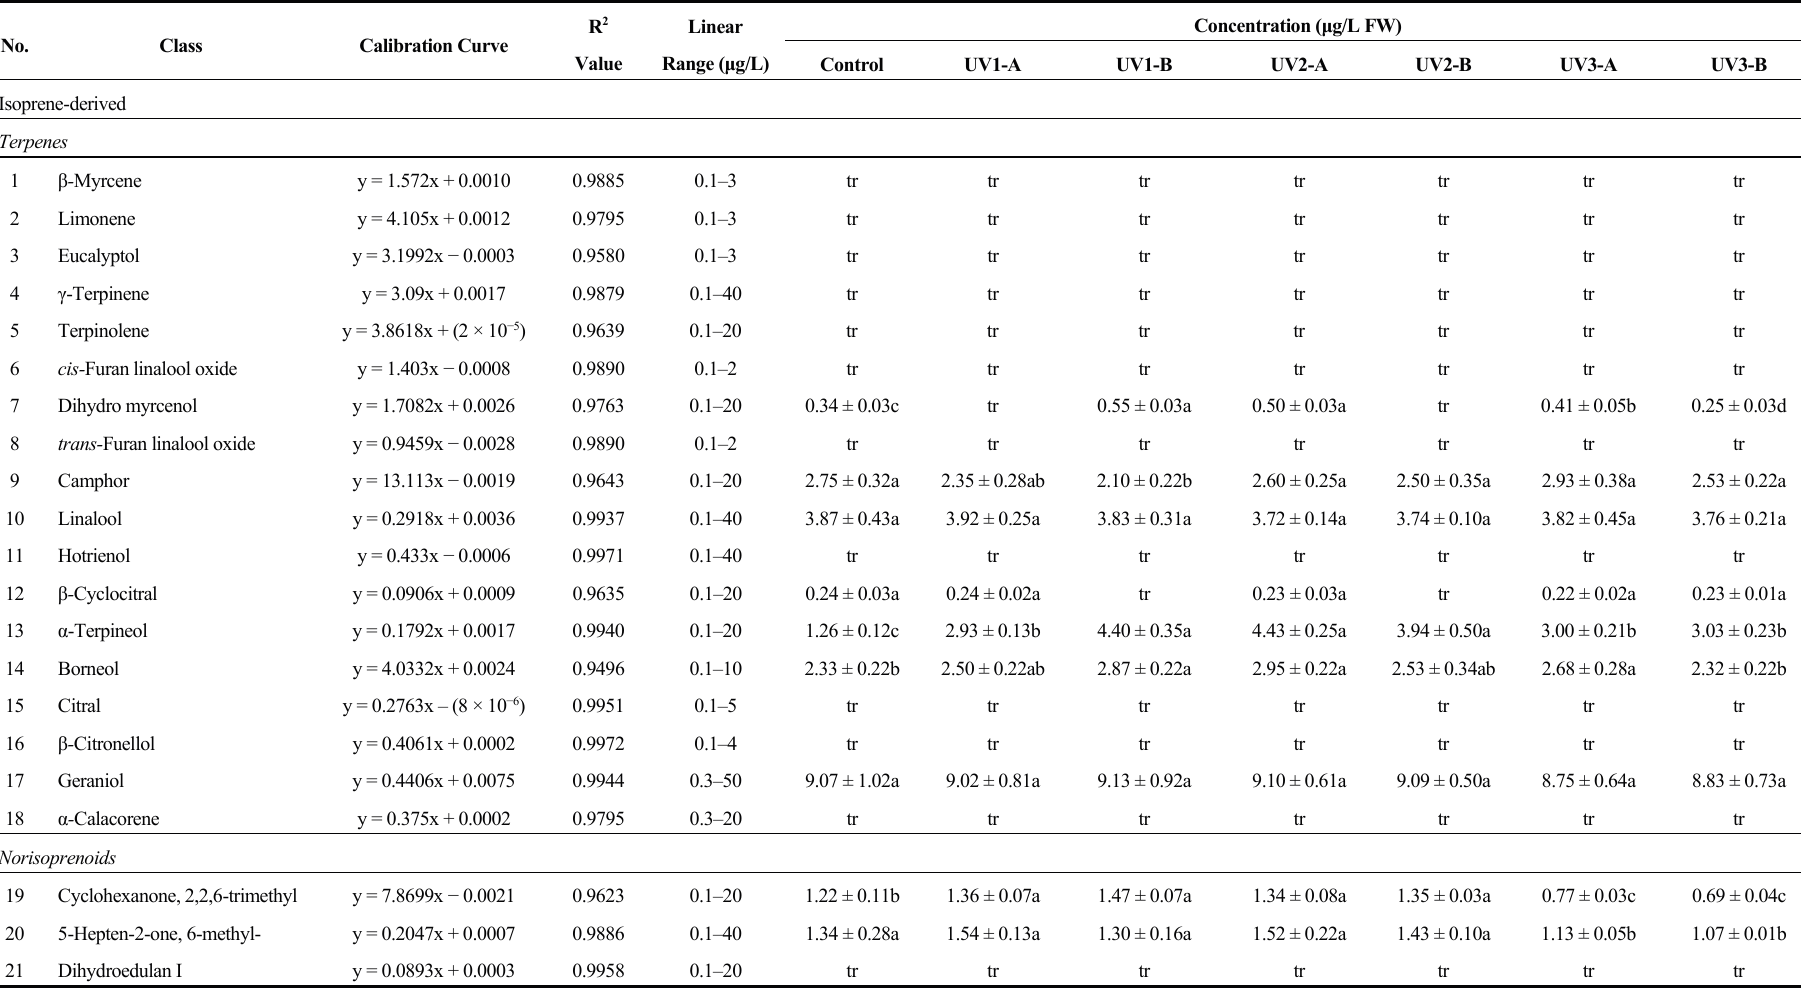
Table 1. Concentrations of various volatile compounds in the grapes at harvest in 2010 under field condition (Control) and attenuated UV radiation ( μ g/L